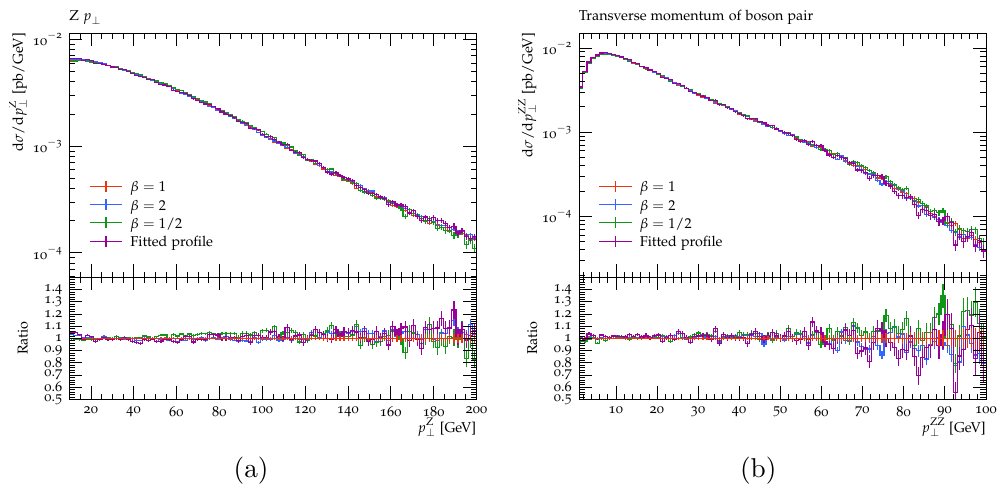
Figure 13 . (a) Transverse momenta of the Z 0 bosons and (b) transverse momentum of the Z 0 Z 0 pair as given by equation (3.22) for a Gaussian form of g ( k ? ; y ) (with three di(cid:11)erent values of (cid:12) ) and for a decreasing Gaussian form ((cid:12)tted pro(cid:12)le). The (cid:12) = 1 setup is the reference in the ratio plots. The histograms are not normalised to